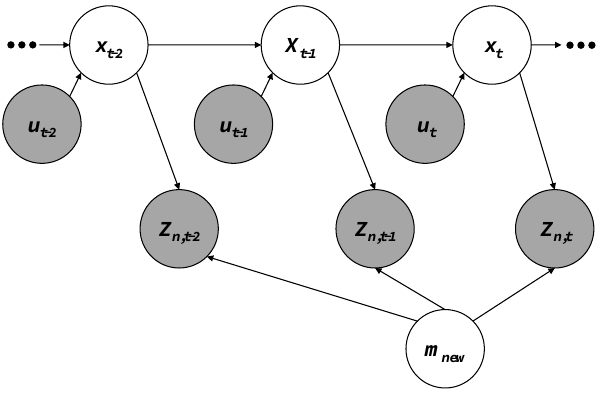
Figure 2. Graph representation for the new feature layer